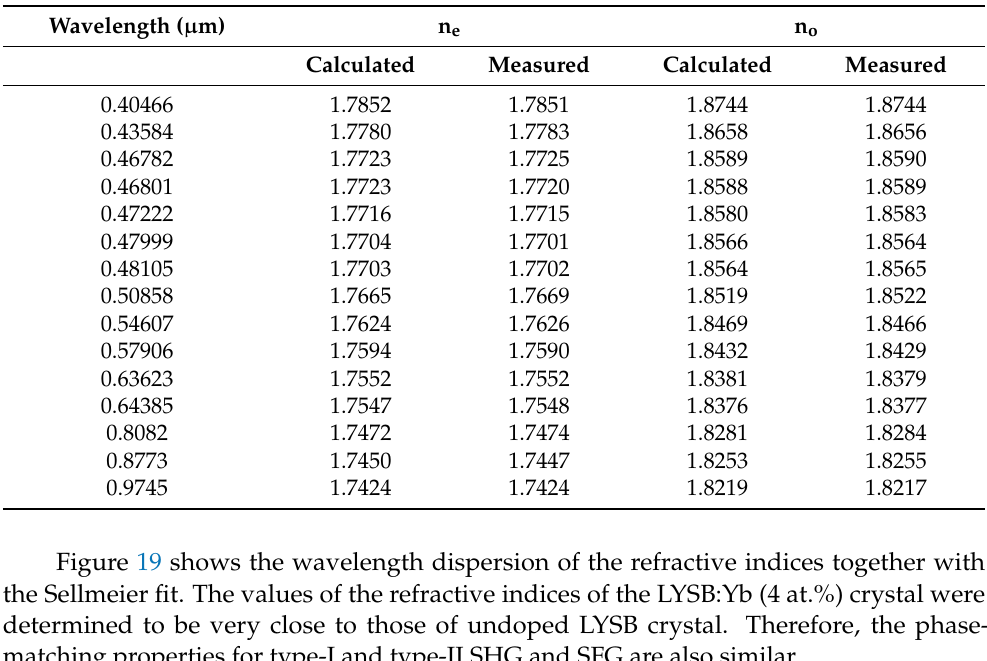
Table 8. Refractive indices of LYSB:Yb (4 at.%) crystal. Reprinted with permission from ref. [45],